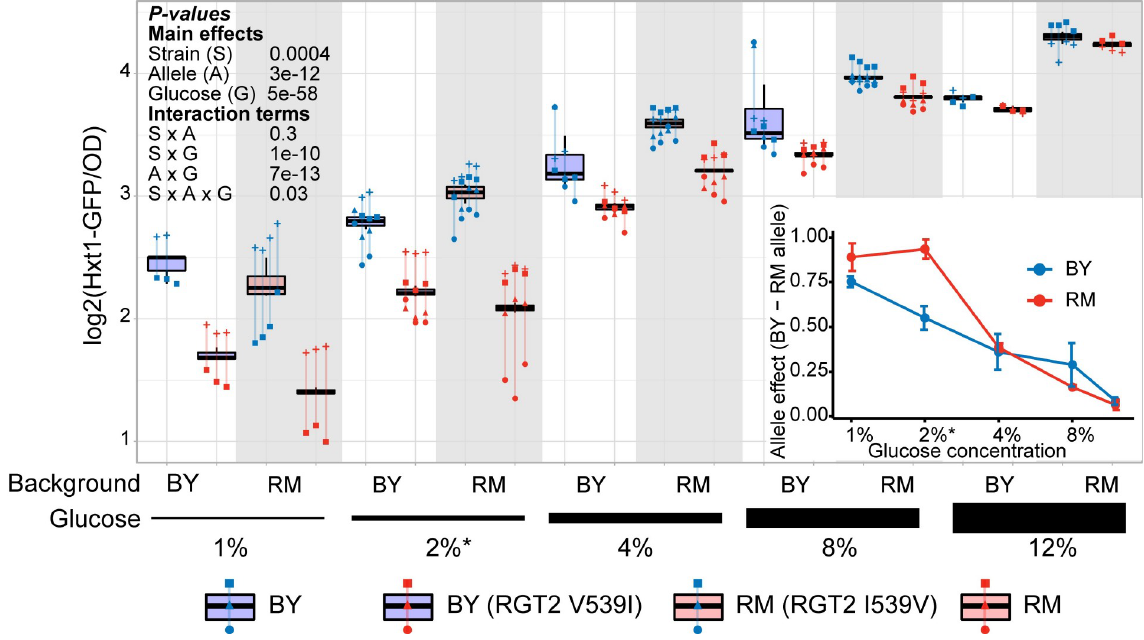
Fig 3. Effect of the RGT2(I539V) variant on Hxt1-GFP expression in different glucose concentrations. Hxt1-GFP fluorescence levels in the four different genotypes in increasing glucose concentrations are shown. The asterisk indicates the glucose concentration used when identifying this eQTL. Blue boxplots indicate alleles in the BY background and red boxplots and gray background shading indicate alleles in the RM background. Lines group measurements of the same clone. Different symbols (circles, squares, etc.) denote different plate reader runs. The inset graph shows fitted effect sizes as a function of glucose concentration. Error bars show standard errors of the mean. P-values are shown for ANOVA models examining the various main and interaction terms.